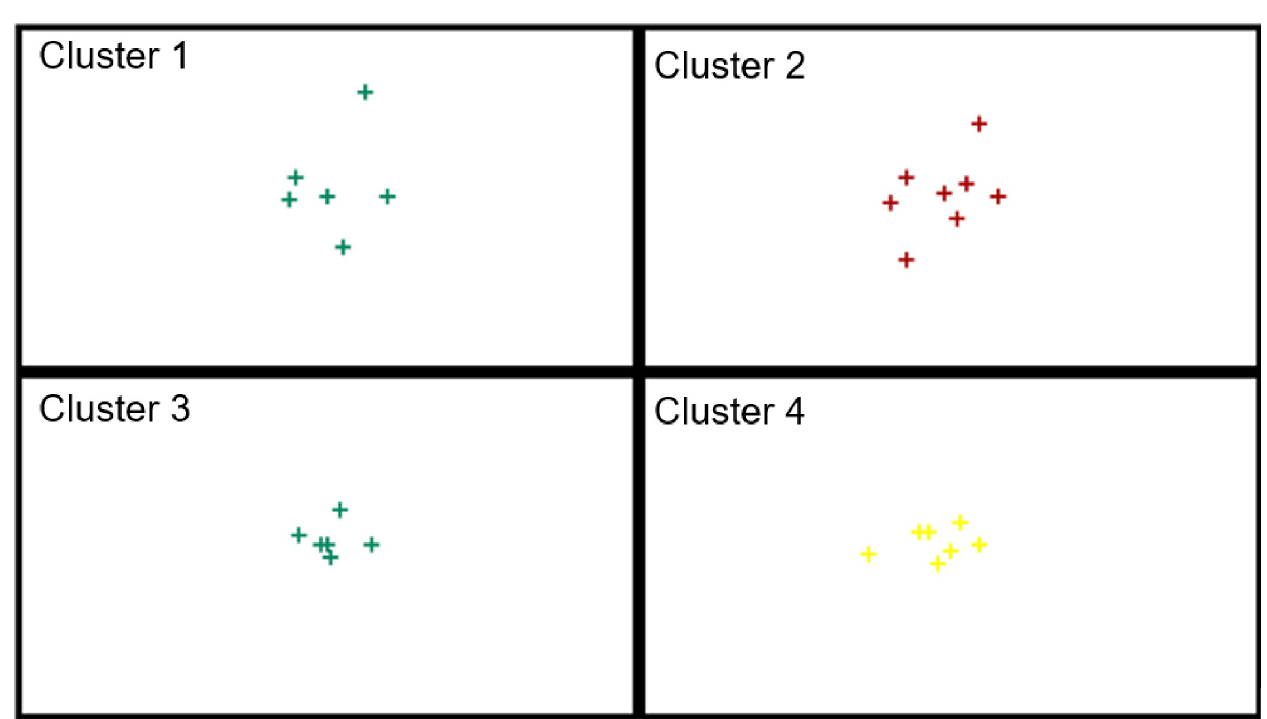
Fig 11. The topological map of similar groups of the EU-27 countries for large